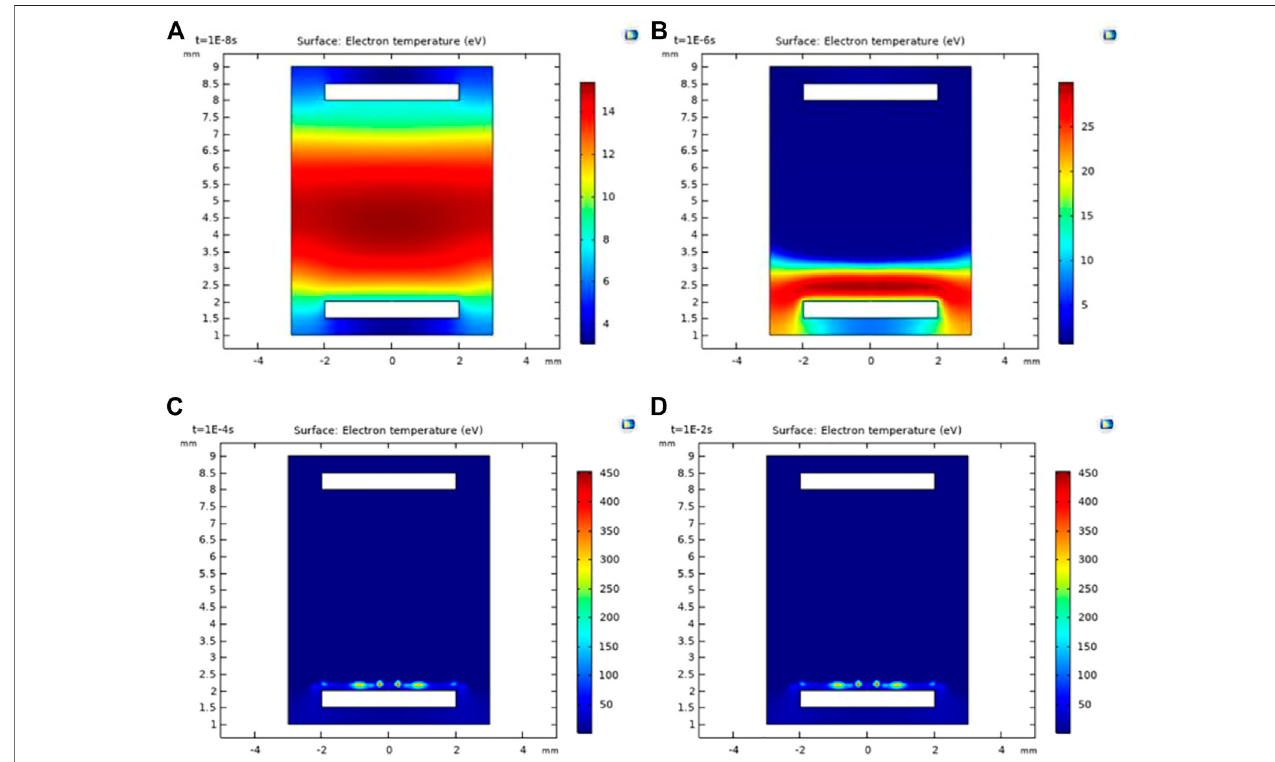
FIGURE 3 | Electron temperature distribution at different times. (A) t (cid:2) 1 . 0 × 10 − 8 s; (B) t (cid:2) 1 . 0 × 10 − 6 s; (C) t (cid:2) 1 . 0 × 10 − 4 s; (D) t (cid:2) 1 . 0 × 10 − 2 s.